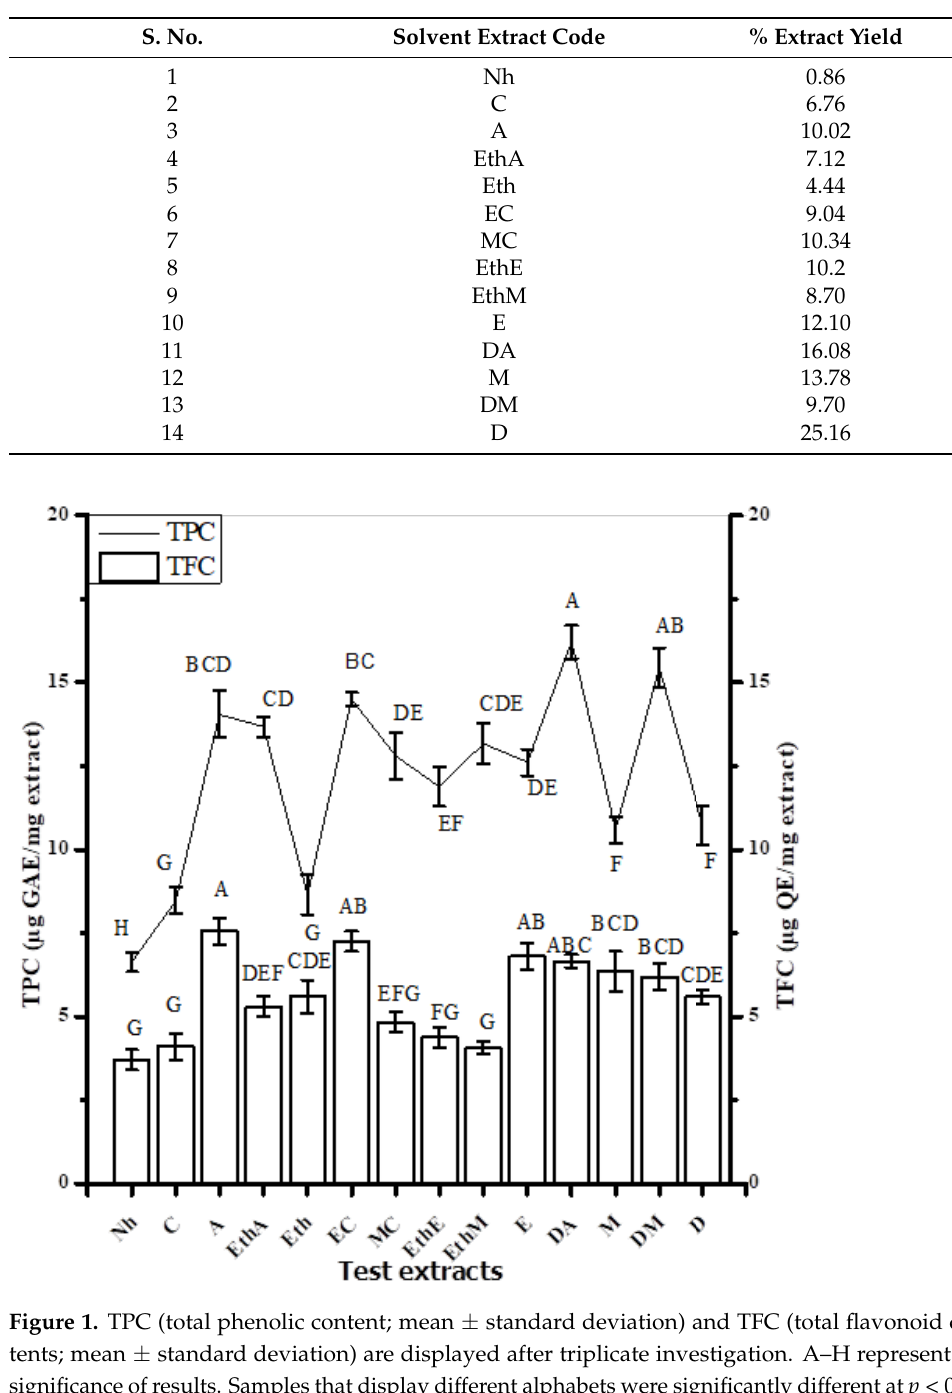
Table 2. Extract recovery.